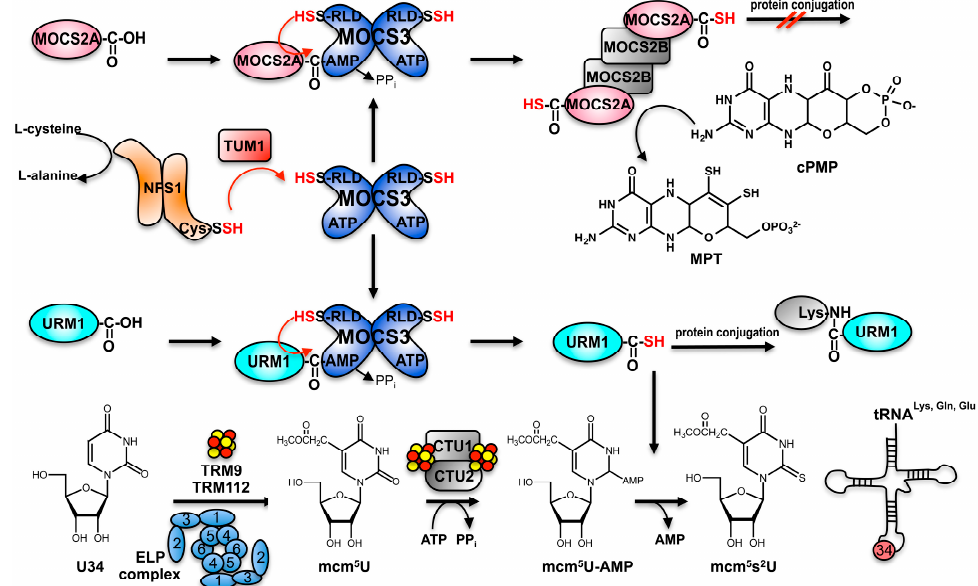
Figure 3. MOCS3 connects the sulfur transfer pathways for the formation of Moco and thiolated nucleosides in tRNA. Formation of the thiocarboxylate group on MOCS2A (upper part). cPMP is converted to MPT by the transfer of two sulfur groups from MOCS2A. MOCS2A is regenerated by MOCS3. The sulfur donor for the persulfide group on MOCS3-RLD is NFS1. Formation of cytosolic 5-methoxycarbonylmethyl-2-thiouridine (mcm 5 s 2 U 34 ) in humans (lower part). Proteins of the elongator complex (ELP) and the tRNA methyltransferases TRM9 and TRM112 proteins